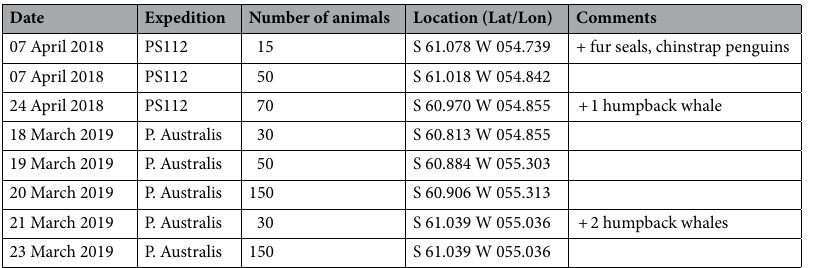
Table 1. Aggregations recorded during RV Polarstern expedition PS112 in 2018 and the Pelagic Australis expedition in 2019. Group size estimates of larger aggregations are best estimates based on counts in the field and evaluation of footage, as exact counting of individuals was not